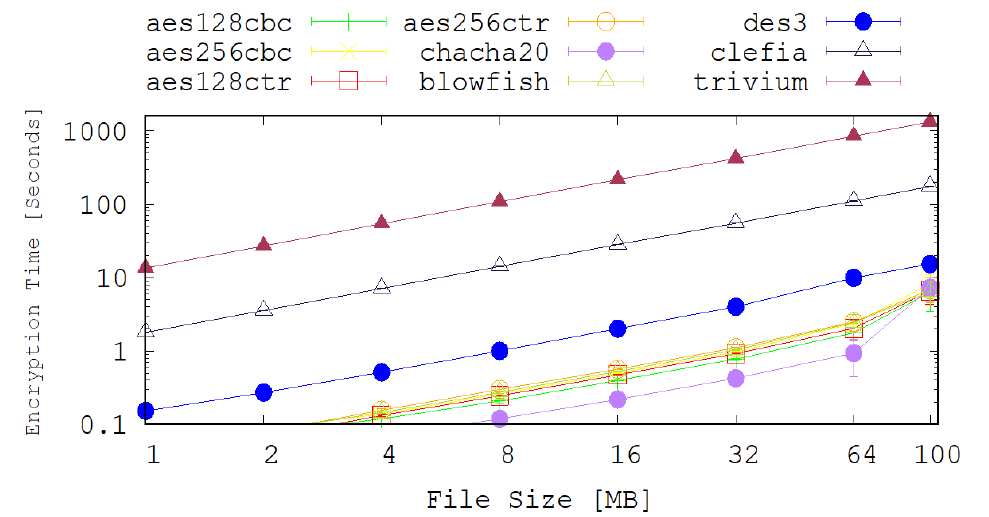
Figure 3. A comparison of the achieved encryption time (in ms) by several legacy and lightweight cryptography algorithms.